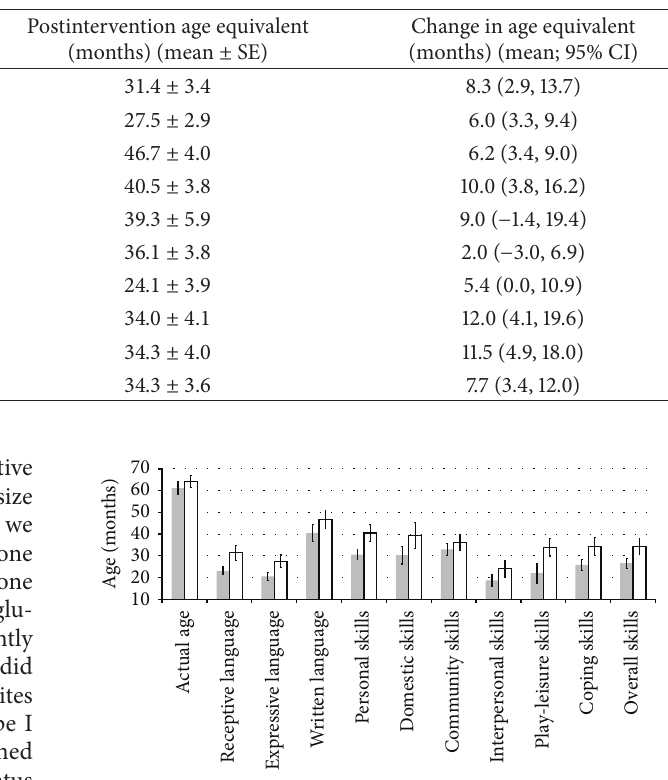
Table 2: Age equivalent scores from the Vineland Adaptive Behavior Scales at baseline before and after 3-month intervention with methylcobalamin and folinic acid. The change in age equivalent scores with 95% confidence interval (CI) is also given. The overall average of all subscales is also given in the last row of the table.